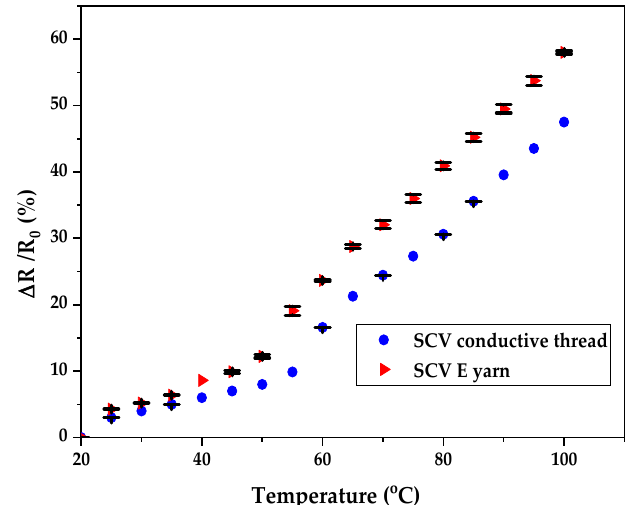
Figure 12. Effects of temperature in electrical resistance.